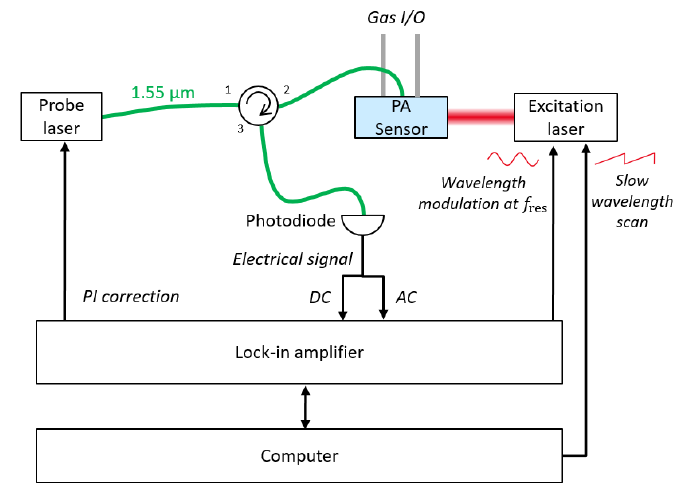
Figure 12. Diagram of the photoacoustic measurement setup. Optical fibers are drawn in green and electric connections in black.